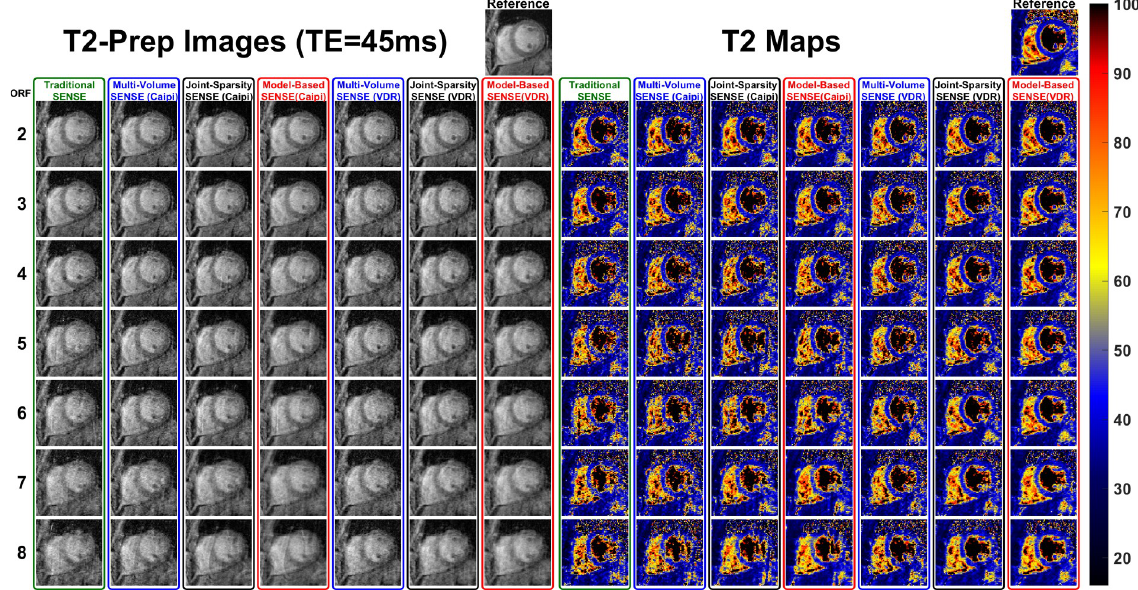
Fig 2. T2-weighted images and T2 maps of a normal human subject with ORF = 2–8 and all reconstruction approaches. T2-Prep TE is 45 ms in the T2-weighted images. As ORF increases (top to bottom), images from all approaches appear noisier and blurrier, and additionally images from traditional SENSE and Caipi sampling patterns suffer from ghosting artifacts. The complete dataset including all slices for all reconstructions can be seen in S1 Video.